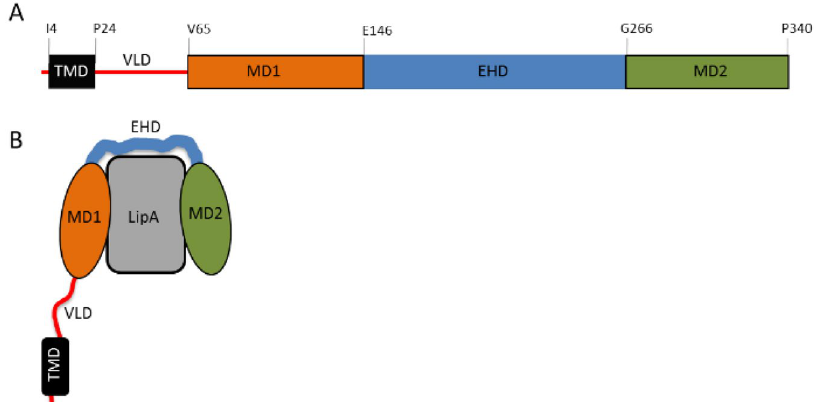
Figure 1. Schematic representation of P. aeruginosa Lif and its complex with lipase LipA. ( A ) Five-domain organization of Lif and ( B ) Lif-LipA complex. The catalytic folding domain (CFD) self-sufficient for activation of LipA in vitro comprises MD1, EHD and MD2. Residues defining the beginning and the end of each domain are indicated in ( A